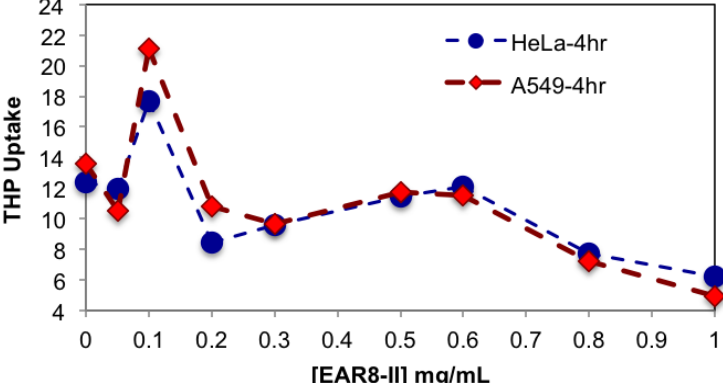
Figure 8. Normalized fluorescence emission intensity of THP uptake by HeLa and A549 cell lines treated with the complexes for 4 h at fixed [THP] = 0.1 mg/mL and [EAR8-II] = 0.05–1.0